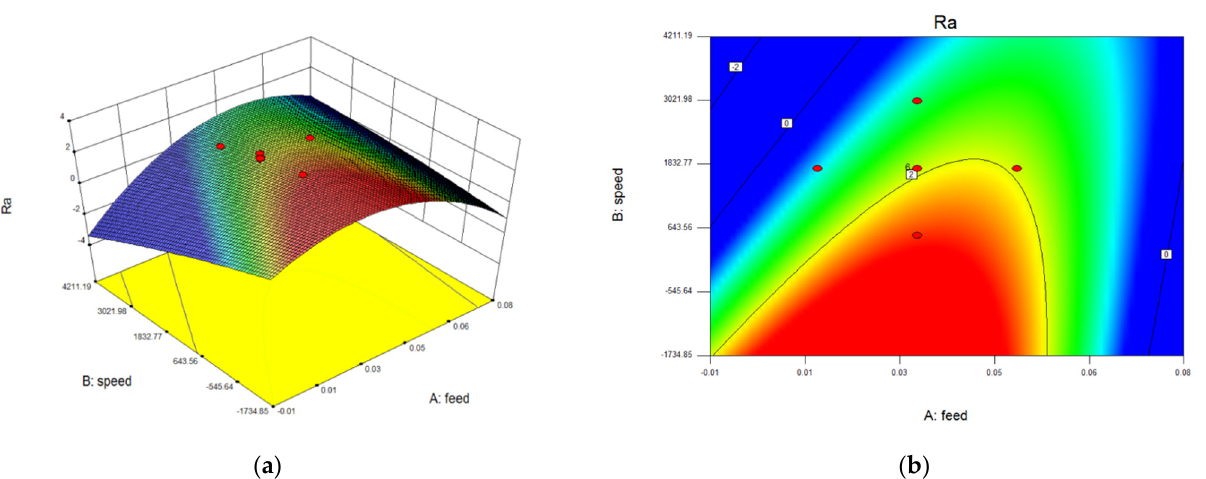
Figure 5. 3D surface plot and contour plot of R a for A and B: ( a ) 3D surface plot; ( b ) contour plot. The red dots in figure indicate the location of the center point in the experimental data distribution graph taken during the experimental design.